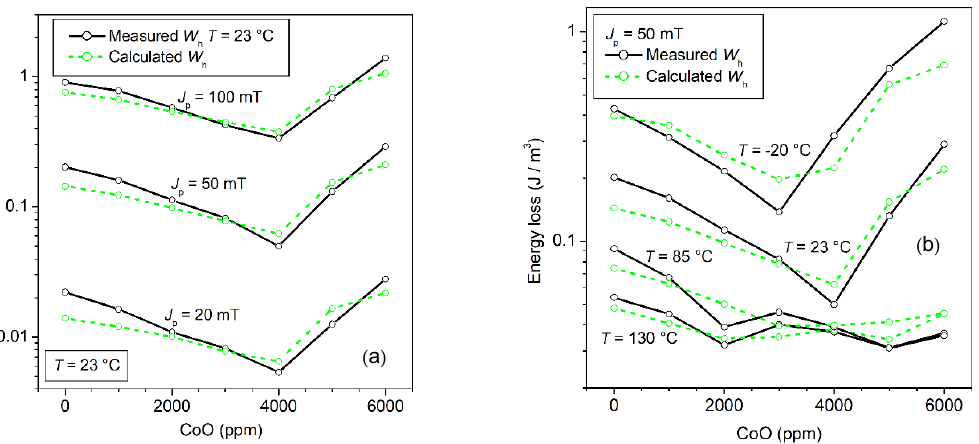
Figure 13. ( a ) The hysteresis energy loss W h measured at T = 23 °C versus CoO content at different J p values is compared with the prediction made through Equation (7). We make use in this equation of the experimental quantities < K eff > (Figure 12b), J s , μ rot,DC , μ dw,DC , and < s >, and a parameter a ( J p ) ~ ∝ J p1.1 , independent of the CoO content. ( b ) The same predicting equation leads to the calculated W h versus CoO at defined J p value and different temperatures, broadly reflecting the evolution of < K eff > in Figure 12b at such temperatures. (Adapted from Ref. [42]).